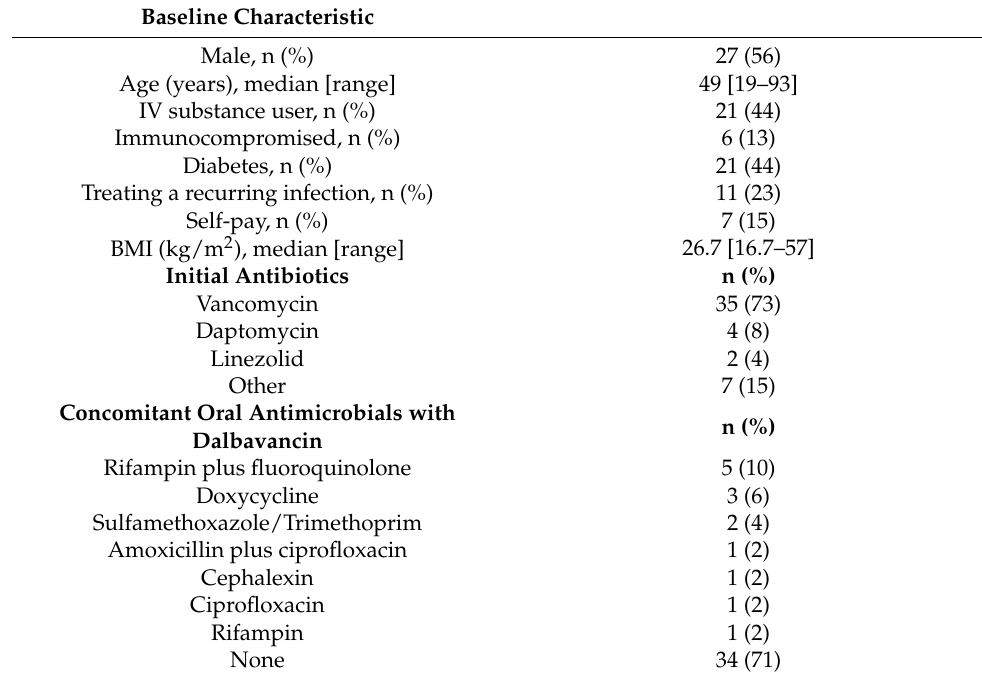
Table 1. Patient Characteristics (N = 48).